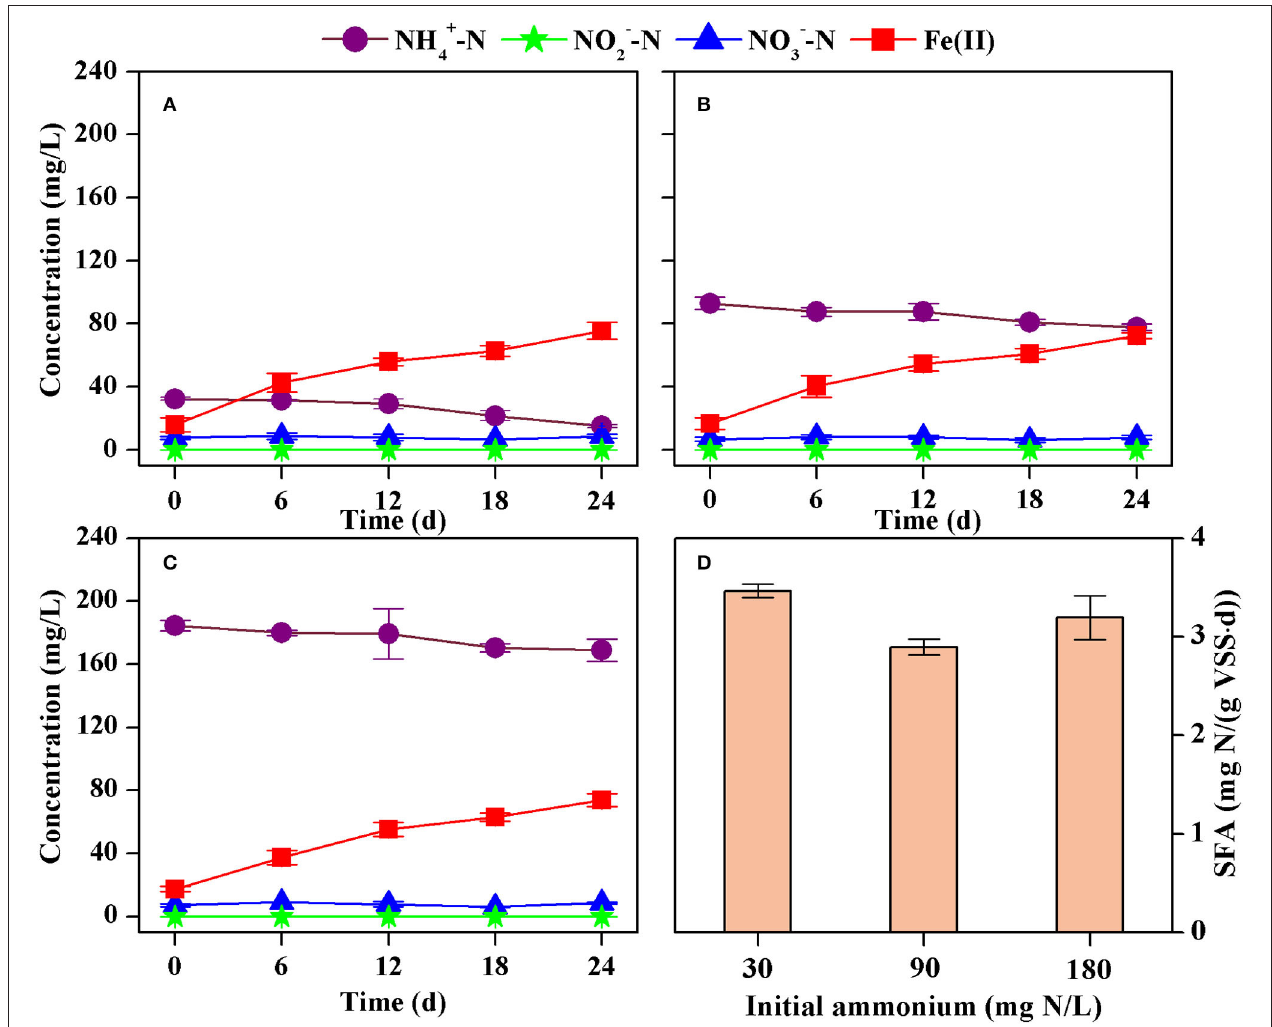
FIGURE 4 | Concentrations of ammonium, nitrite, nitrate, and Fe(II) in the batch tests with different initial ammonium concentrations [ (A) 30mg N/L, (B) 90mg N/L, (C) 180mg N/L], and the estimated specific Feammox activity of ammonium oxidation (D)